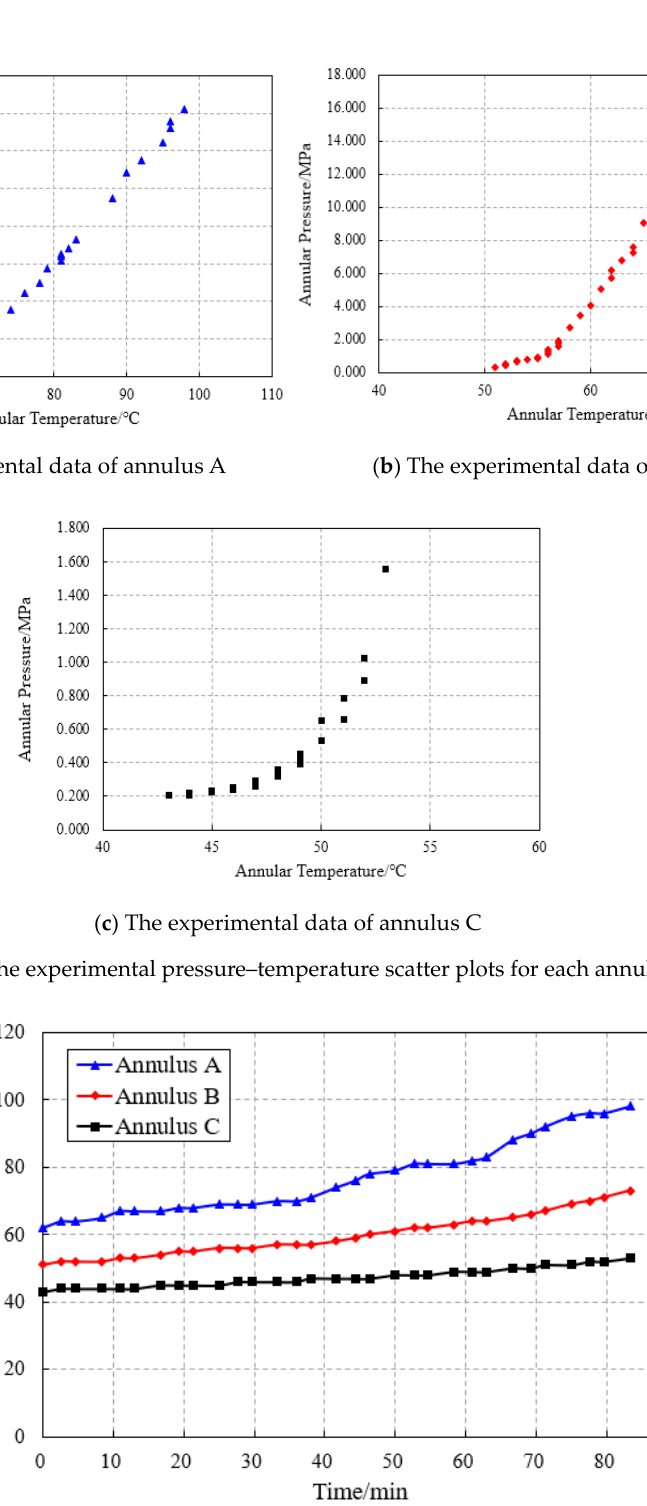
(1) In this work, a modified integral model based on the EOS was used to analyze the ex- perimental data of APB. As each annulus was sealed, the mass of fluid was considered con- stant. According to the EOS, the pressure is a function of temperature and fluid volume. (2) The APB process can be regarded as the combination of two steps, which are isobaric expansion and isothermal compression. The process is shown schematically in Figure 8.